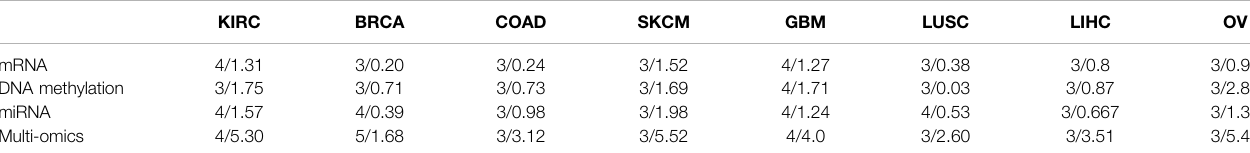
TABLE 2 | Results of multi-omics and single-omics, the fi rst value is cluster number and the second is the negative log10 p -value. KIRC BRCA COAD SKCM